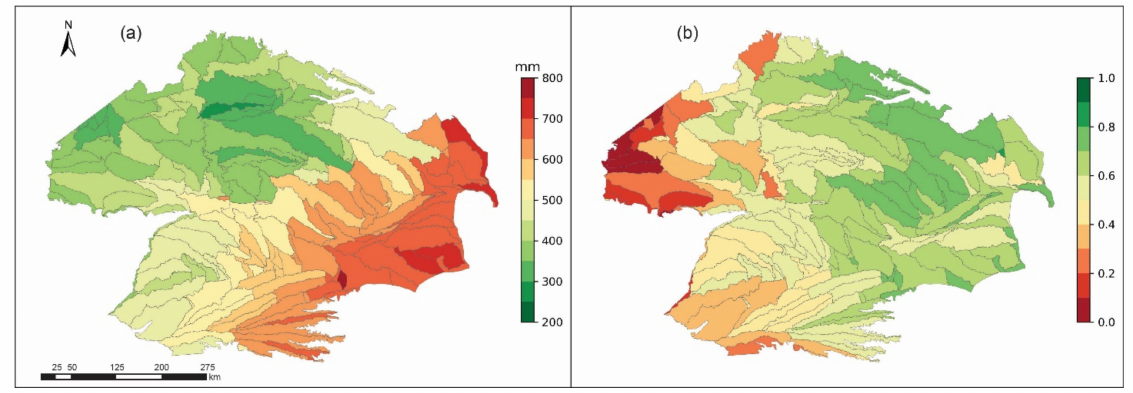
Figure 6. Sub-basin level ( a ) mean annual evapotranspiration simulated by Auto-Irr, and ( b ) R 2 between Auto-Irr simulated and MODIS evapotranspiration on a monthly scale from